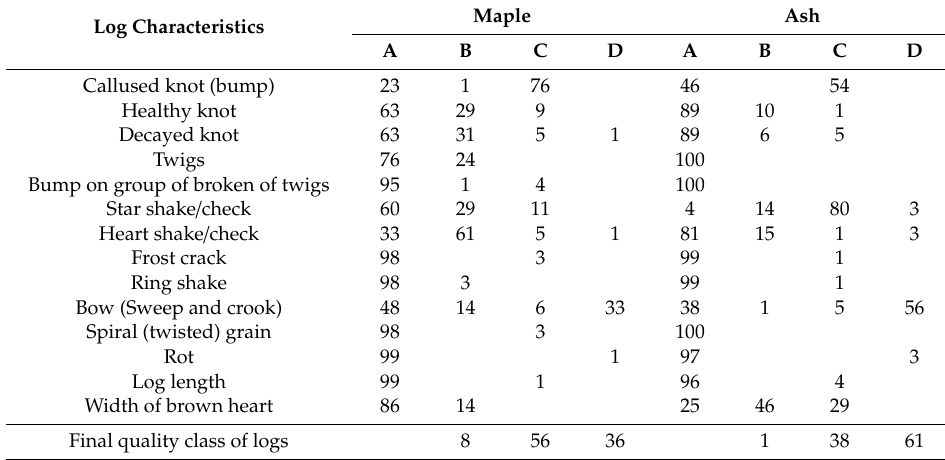
Table 5. Yields in % for quality sorting of logs according to RVR [29] separated after sorting criteria (log characteristics).